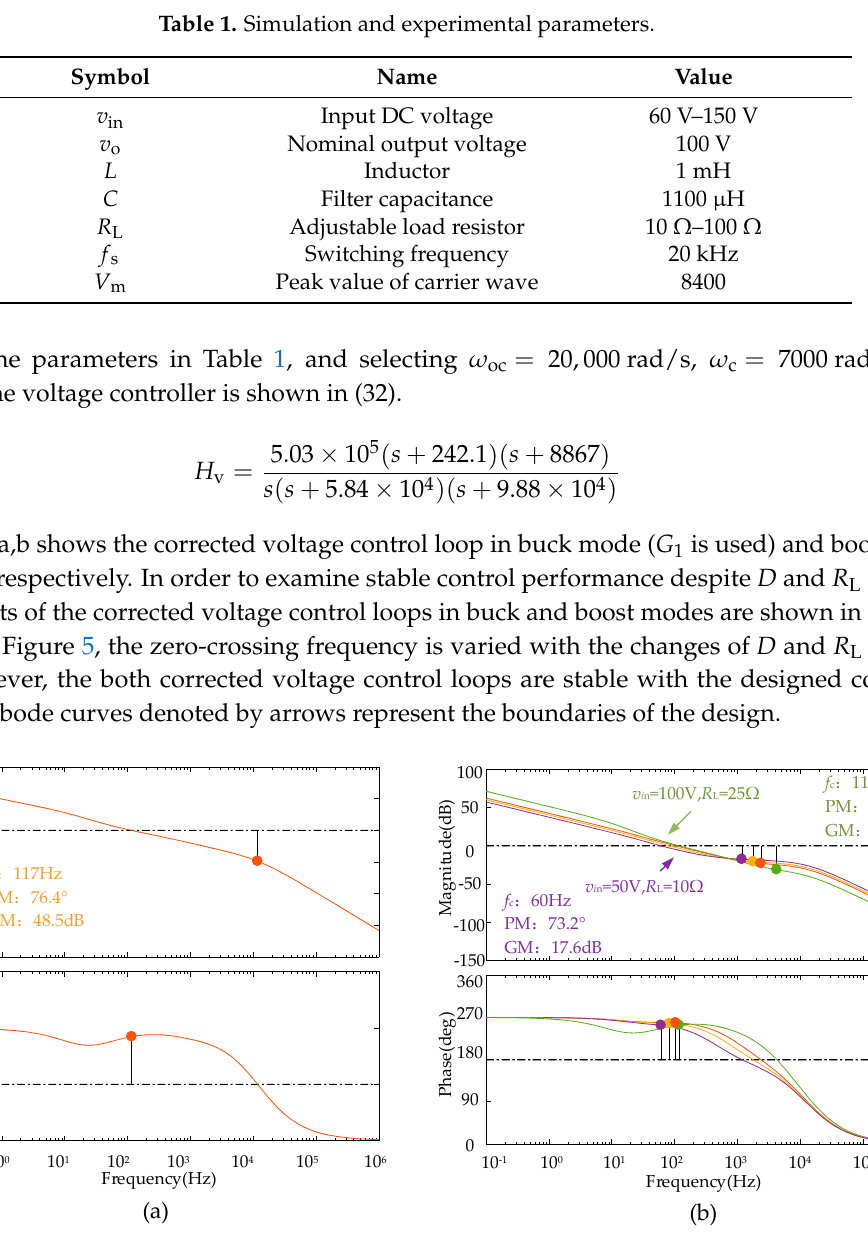
(b) Figure 6. The simulation results: ( a ) Input/output voltage and current and ( b ) duty cycles and driving signals . The effectiveness of the proposed method is validated by developing a hardware test circuit shown in Figure 7. Two modules of IGBT (Insulated Gate Bipolar Transistor , FF200R12KT4) are used to constitute the power circuit of the converter; the driving pulses for the two IGBTs are produced by 2SD106AI modules. The inductor current, i L , and the output voltage, v o , of the double-switch